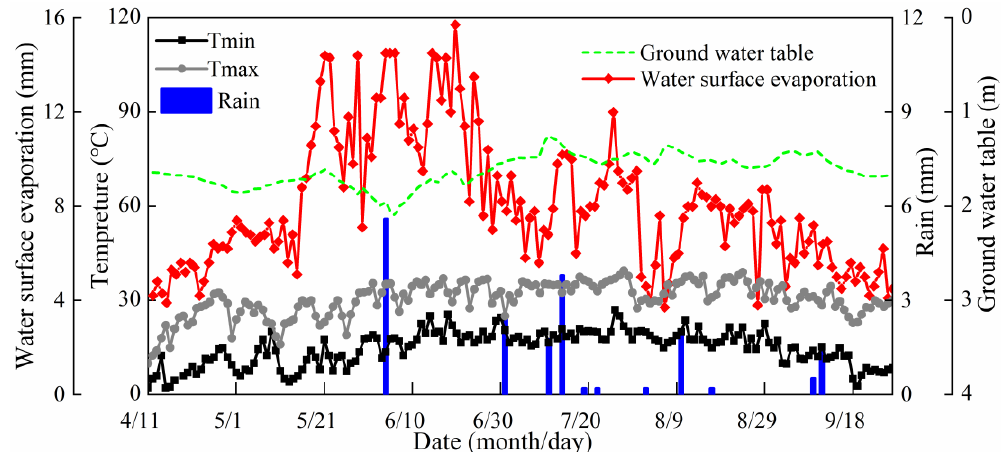
Figure 2. Variation in temperature, rainfall, water surface evaporation and groundwater table. Table 1. Soil physical and chemical properties at the experimental site.